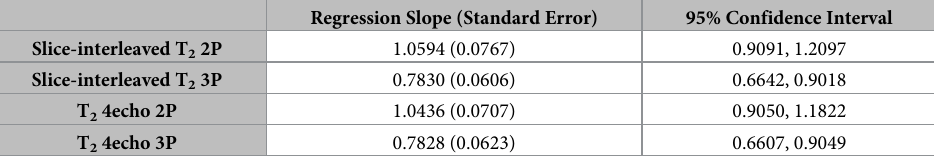
Table 5. Linear regression of slice-interleaved T 2 mapping sequences against the reference SE T 2